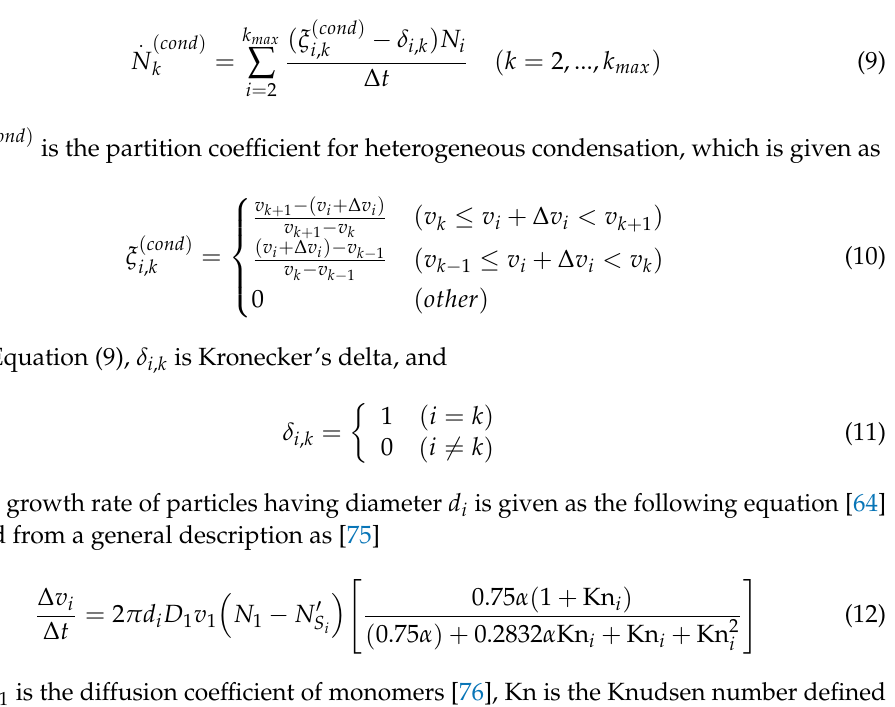
Figure 2b represents a schematic image of calculation for heterogeneous